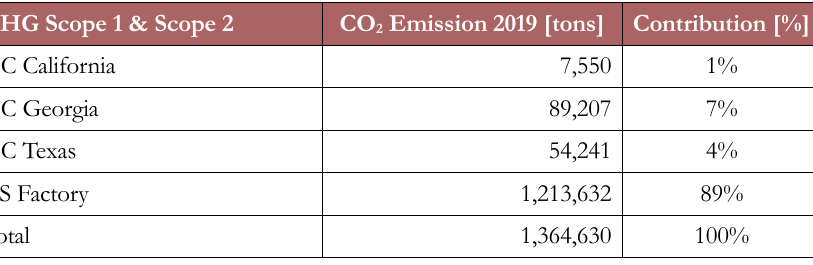
Table 5. Carbon emission split under